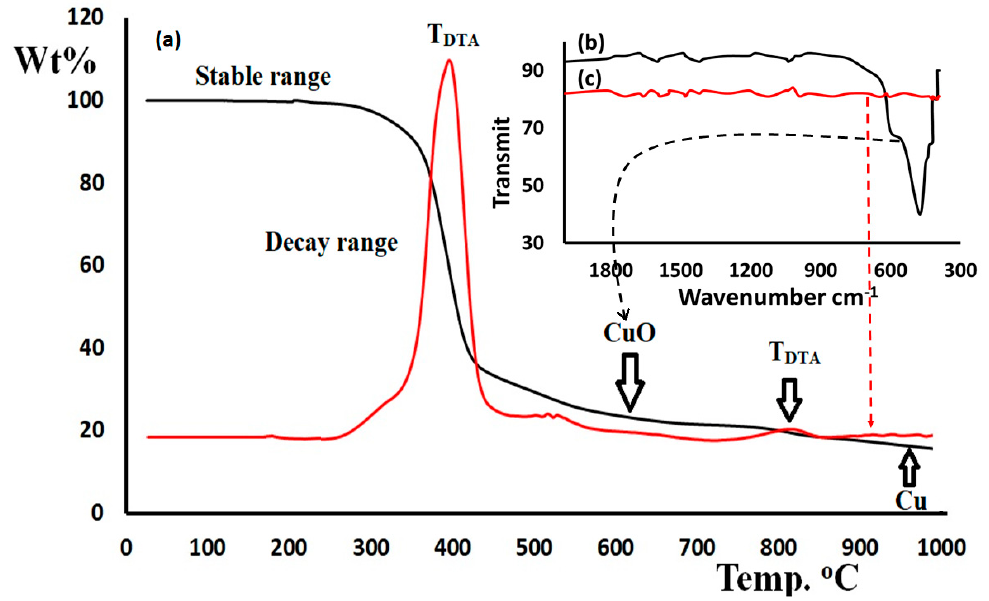
Figure 9. TG-DTA of the cis -Cu(II) complex ( a ), FTIR of CuO ( b ), and Cu ( c ).